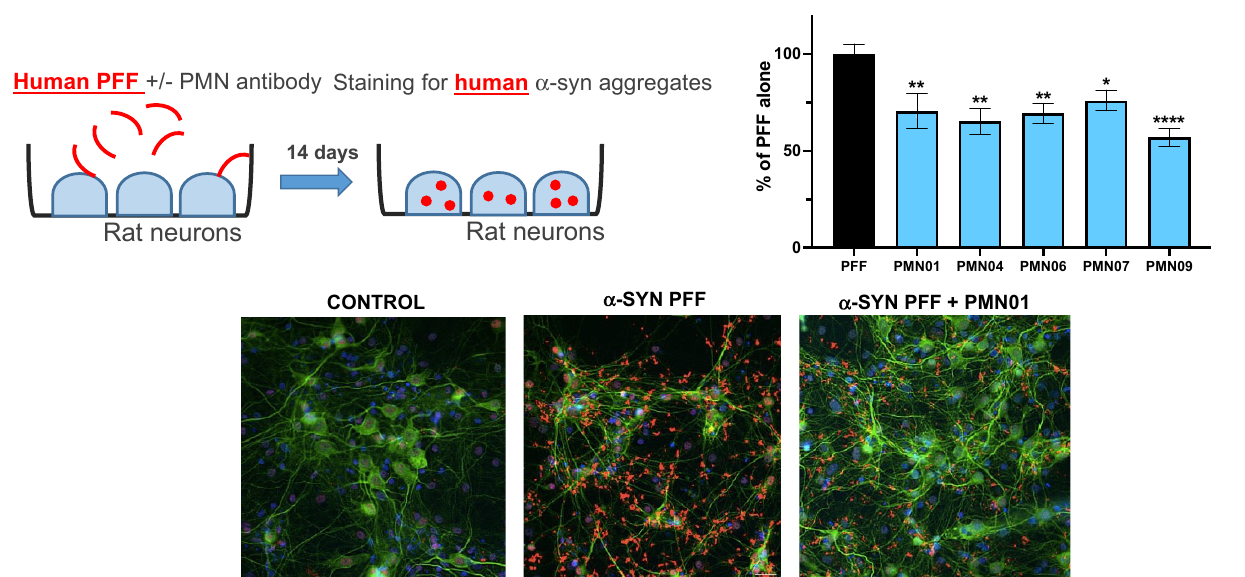
Figure 10. mAb inhibition of PFF uptake and intracellular aggregate formation. Cultures of primary rat hippocampal neurons were exposed to sonicated human PFF (1 µg/mL) without or with mAbs (0.05 µM, except for PMN09 at 0.25 µM). Cultures were stained 14 days later for neuronal marker MAP2 ( green ), aggregates of human α -syn ( red ) and cell nuclei ( blue ). Results are expressed as a percentage of the human α -syn staining area with PFF alone and show the mean ± SEM of 6 replicate cultures. A global analysis of the data was performed using one-way ANOVA followed by Dunnett’s multiple comparisons test. * p ≤ 0.05, ** p ≤ 0.01, **** p ≤ 0.0001 vs. PFF.